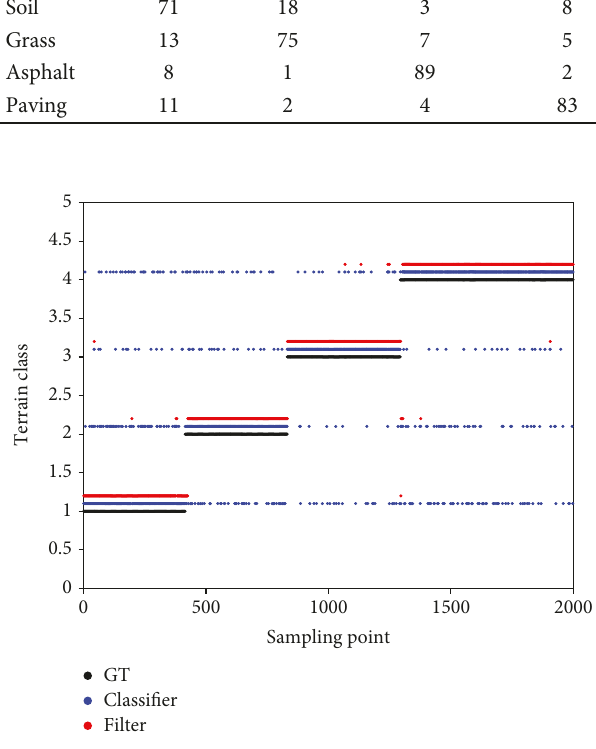
Figure 5: Filtering results. “ GT ” stands for the real terrain, “ classi fi er ” stands for the classi fi er output, and “ fi lter ” stands for the fi lter output.